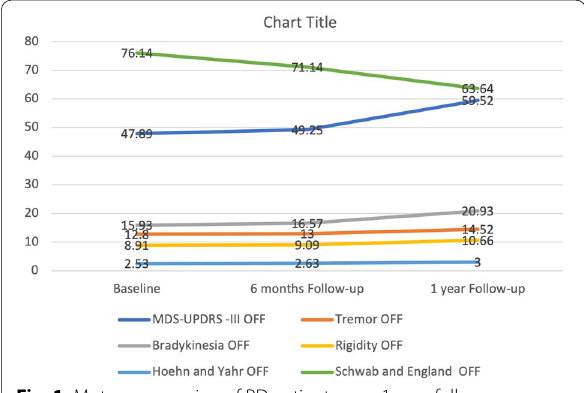
Fig. 1 Motor progression of PD patients over 1‑year